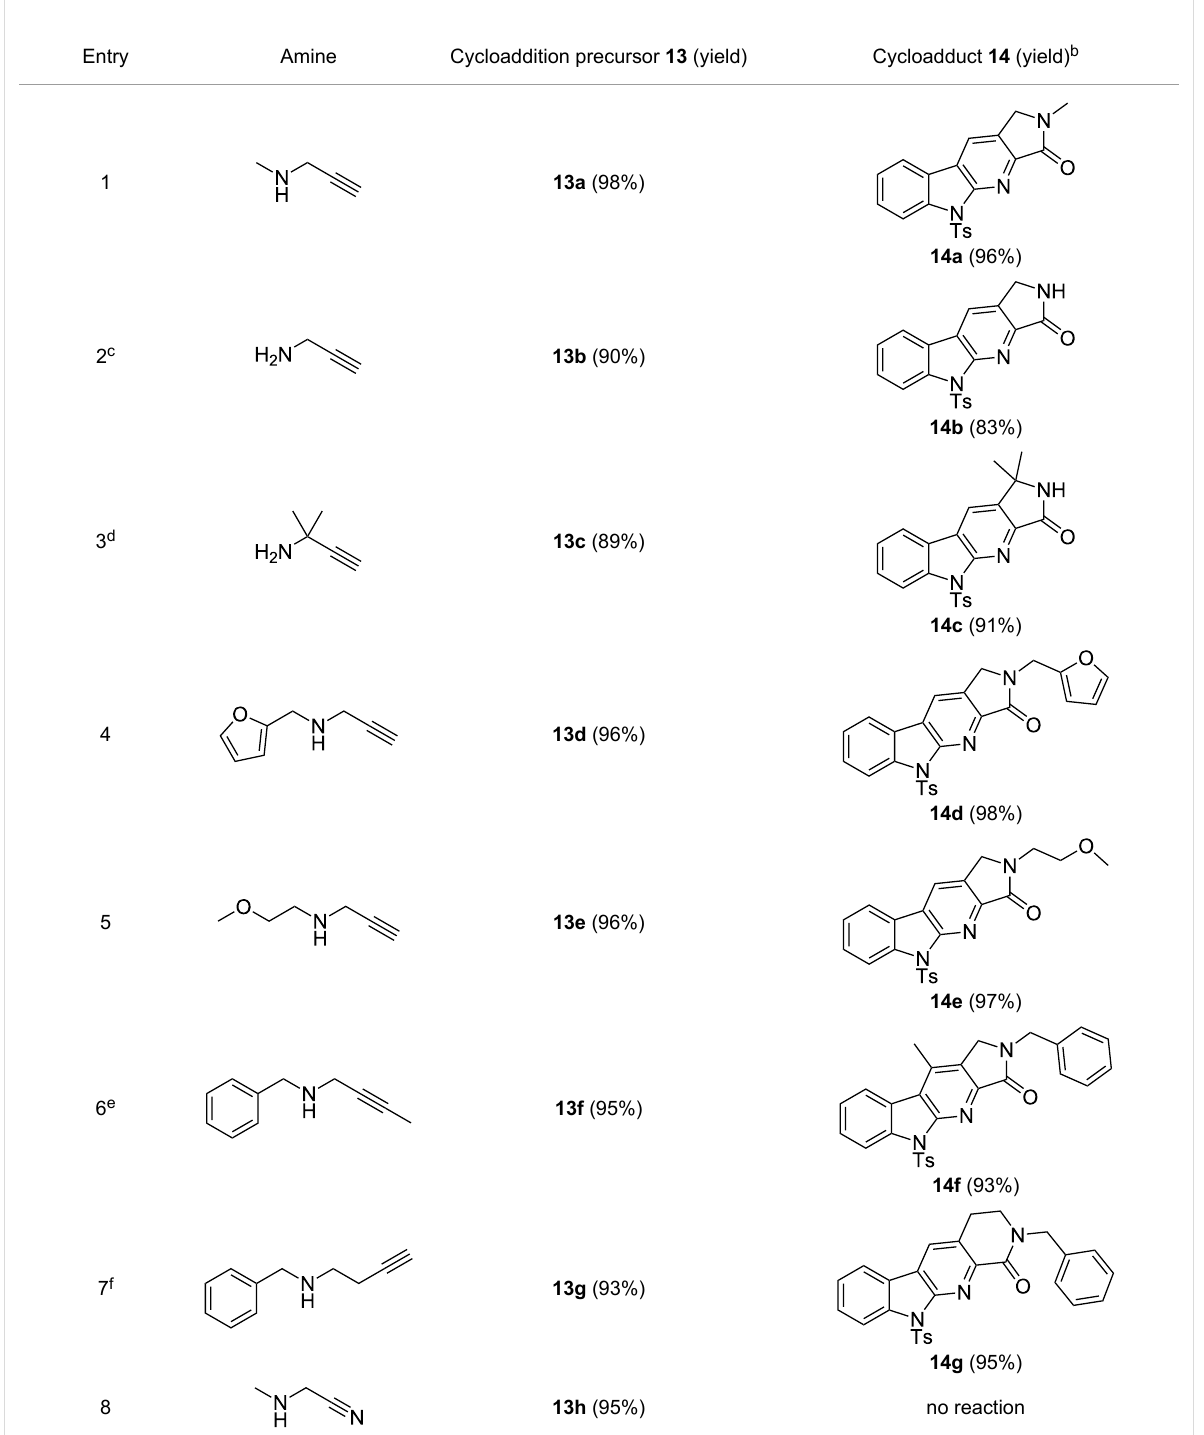
Table 4: Amidation-IEDDA sequence to α -carbolines 14 from triazine 8a .